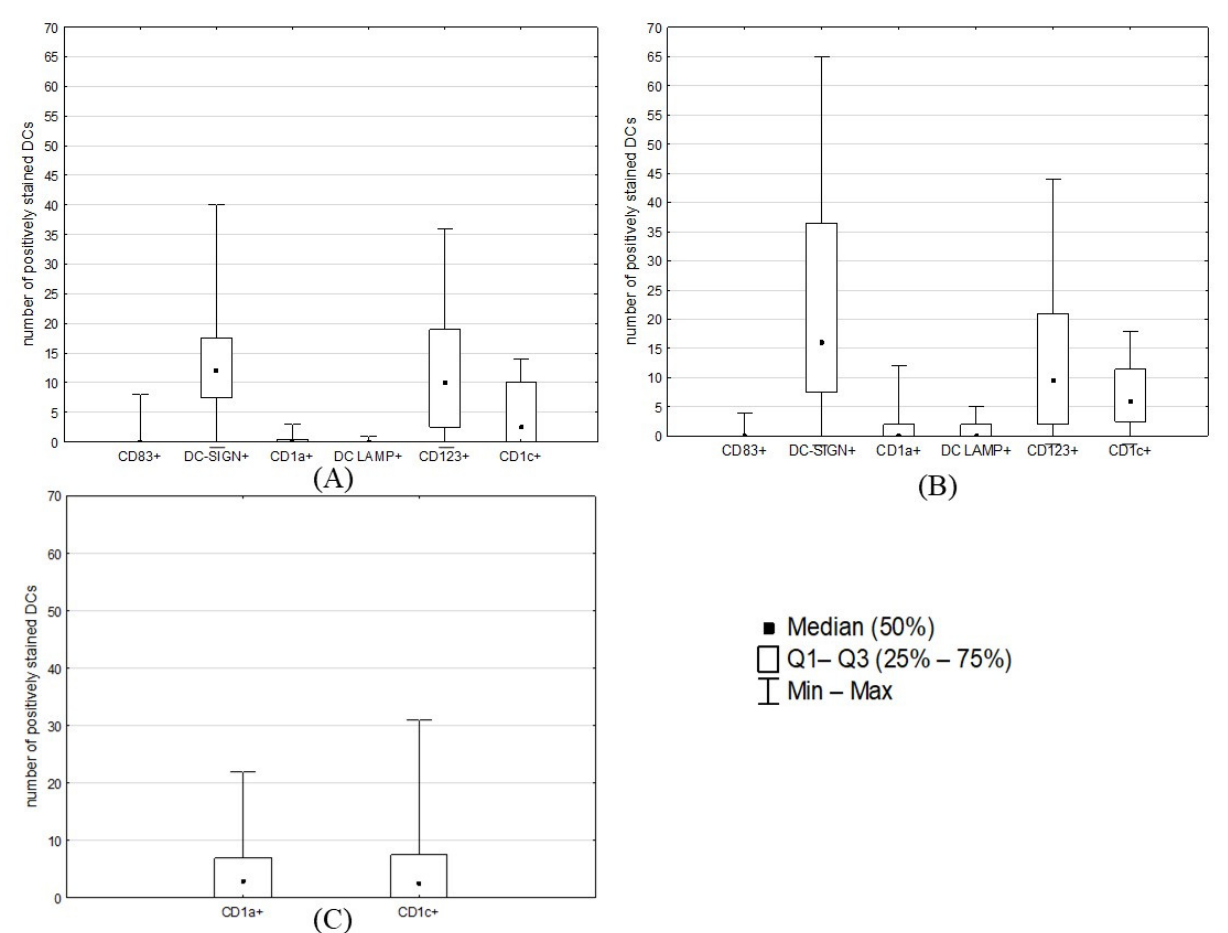
Figure 6. Median counts (/mm 2 ) of DC subtypes in: ( A ) normal endometrial margin; ( B ) normal endometrial stroma; ( C ) in normal endometrial glands (CD1a+ and CD1c+ DCs were the only DCs subtypes found in normal glandular epithelium). The graph shows the median, minimal, and maximal numbers of DCs positively stained for different antibodies (counted in five fields of view) as well as values of quartile 1 (Q1) and quartile 3 (Q3). Areas of non-cancerous endometrium within EC slides were initially examined at 10 × magnification; within areas most abundant in positively identified DCs, their numbers in five representative fields of view were summed up at high (40 × ) magnification and expressed per 1 mm 2 . Table 3. Differences in numbers of different DC subtypes between ECs and normal endometrium. For all evaluated areas and all used antibodies, EC tissues were significantly more heavily infiltrated by DCs than normal endometrium. The statistics were calculated using the Mann–Whitney U test (* p < 0.05 was considered statistically significant).